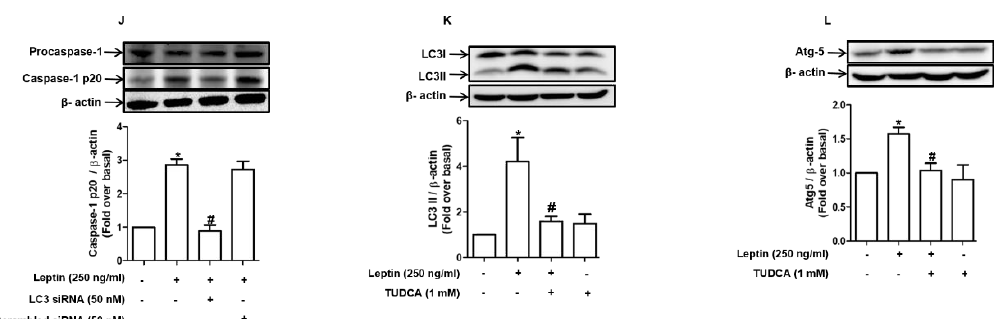
Figure 5. Role of autophagy induction in inflammasome activation by leptin in rat hepatocytes: ( A – D ) Hepatocytes were treated with leptin (250 ng/mL) for different time durations. Expression levels of the genes related to autophagy, including LC3I/II ( A ), Atg5 ( B ), Beclin-1 ( C ), and p62 ( D ), were measured by Western blot analysis. ( E , F ) Cells were pretreated with bafilomycin A, a lysosomal inhibitor, for 1 h followed by further stimulation with leptin for 8 h. Expression levels of LC3I/II ( E ) and p62 ( F ) were analyzed by Western blot analysis. ( G , H ) Hepatocytes were incubated for 1 h in the absence or presence of 3-MA followed by further incubation with leptin for 8 h. Active IL-1 β ( G ) and caspase-1 ( H ) levels were determined by Western blot analysis. ( I , J ) Cells were transfected with the siRNA targeting LC3B or scramble control siRNA. After 24 h incubation, cells were further stimulated with leptin for 8 h. Active IL-1 β ( I ) and caspase-1 ( J ) levels were assessed by Western blot analysis. Gene silencing efficiency of LC3B was monitored by Western blot analysis and is presented in the upper panel of ( I ). ( K , L ) Cells were pretreated with TUDCA for 1 h followed by treatment with leptin (250 ng/mL) for 8 h. Expression levels of LC3I/II ( K ) and Atg5 ( L ) were determined by Western blot analysis. For Western blot analyses, expression levels of the target genes were quantitiated by densitometric analysis and are shown in the lower panel of each image. Values are presented as fold change compared to the control group and are expressed as mean ± SEM, n = 3. * represents p < 0.05 compared to control cells; # denotes p < 0.05 compared with the cells treated with leptin alone or not transfected with siRNA.